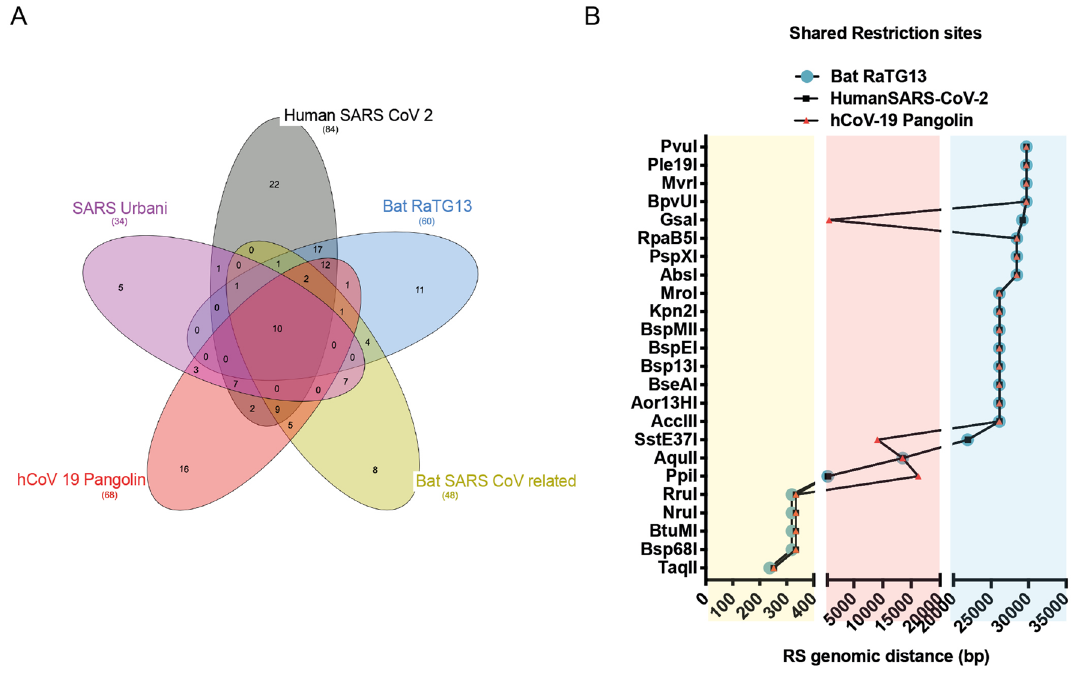
Figure 3. Shared restriction sites and their genomic distance. ( A ) Venn Diagram shows shared RSs between genomes of different viruses. ( B ) Genomic distance in bp of the shared RSs between SARS-CoV-Wu, Bat RaTG13 and the hCoV-19